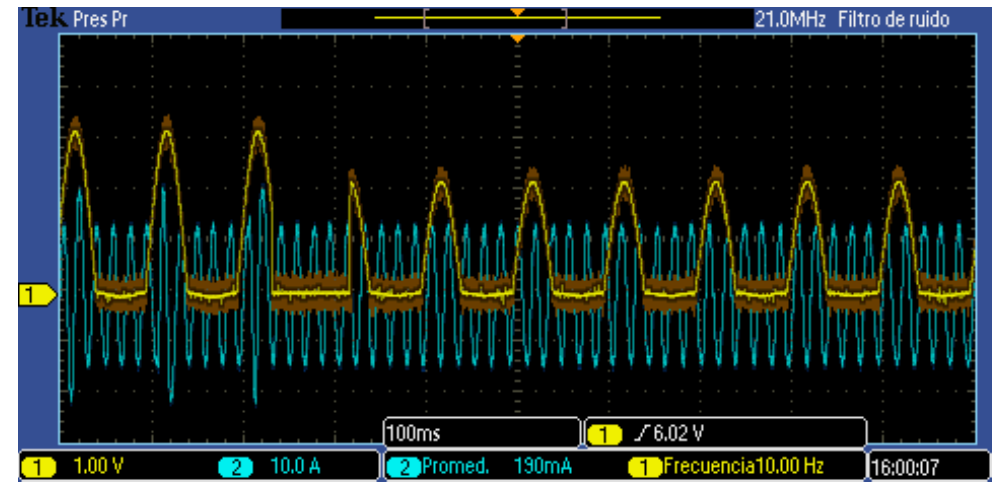
Figure 26. Motor current behavior after a step in the peak current reference from 22 A to 15 A. Pedaling frequency, 10 Hz.